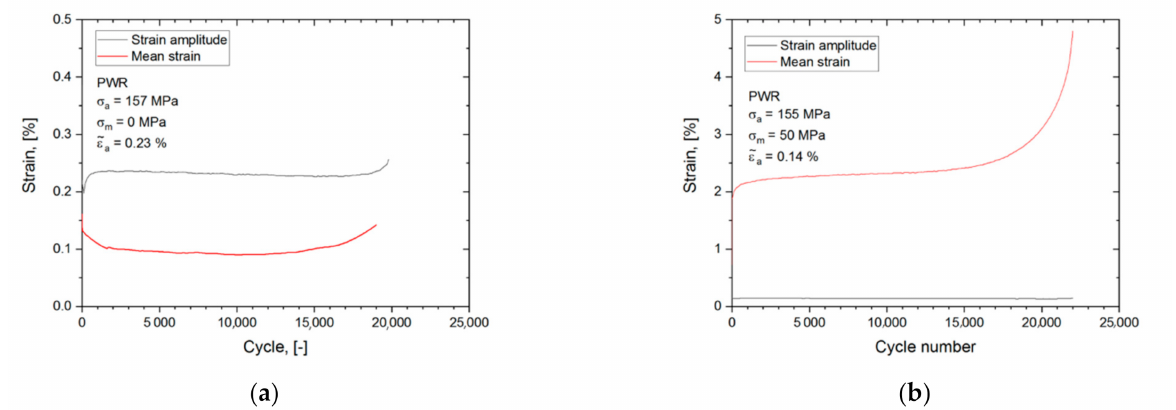
Figure 6. Strain amplitude and mean strain evolution versus cycle at a nominal stress amplitude of 160 MPa in the pressurized water reactor (PWR) with: ( a ) σ m = 0 MPa (left); ( b ) σ m = 50 MPa (right).